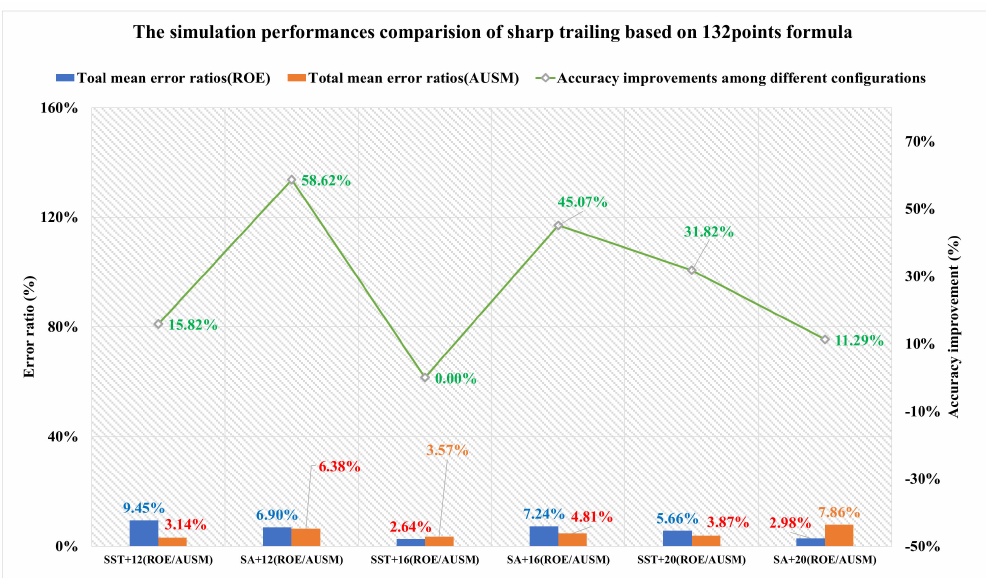
Figure 13. Comparison of the simulation performances of the sharp trailing edge based on 132 points formula under different simulation configurations.